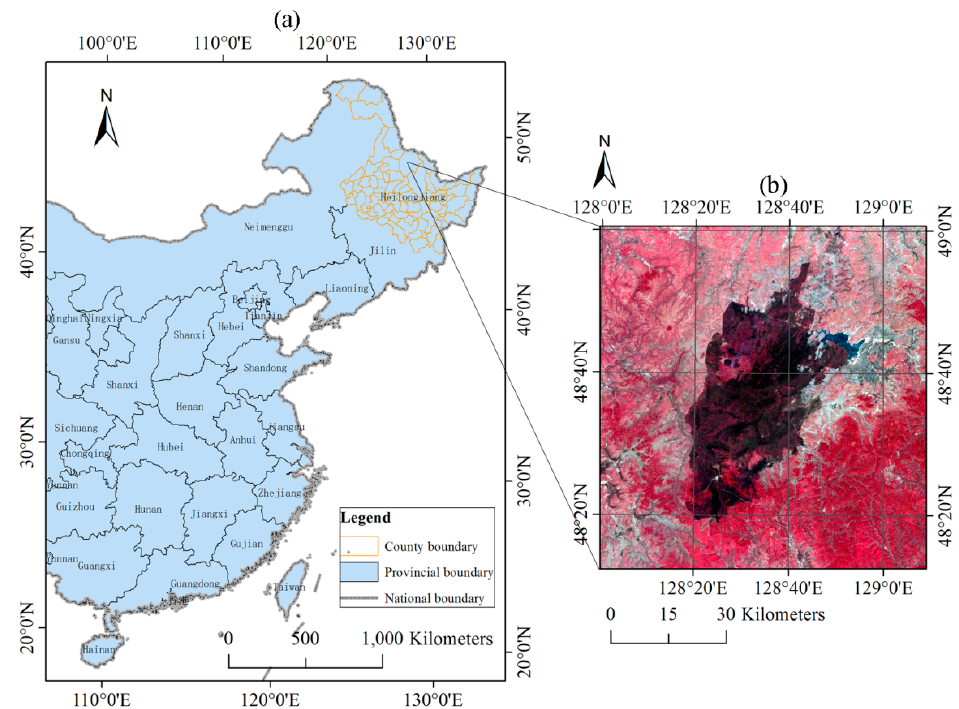
Figure 1. The location of the study area ( a ); and the 30-m HJ-1B CCD false color image (R: Near Infrared (NIR), G: Red, B: Green) acquired on 11 May 2009 ( b ).